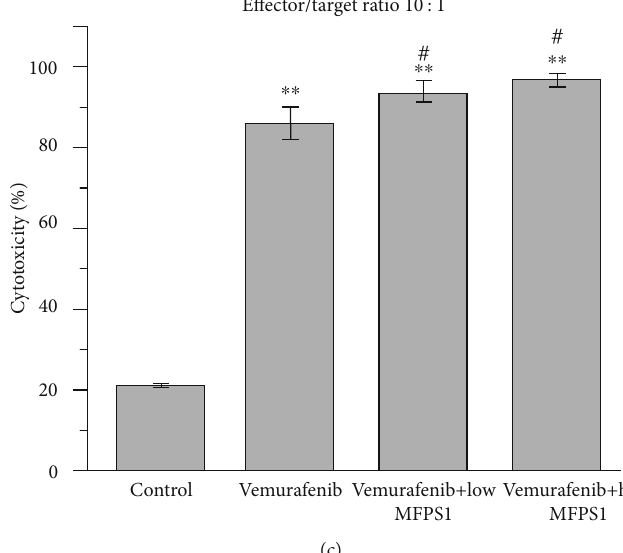
Figure 3: In vivo experiments, MFPS1 enhance the killing e ff ect of Vemurafenib on human melanoma MeWo cells. (a) Killing e ff ects on the human melanoma MeWo cells at target ratios of 1 :1, 5:1, and 10 :1 after drug treatment; (b) killing e ff ects on the human melanoma MeWo cells at target ratio of 5:1 after drug treatment; (c) killing e ff ects on the human melanoma MeWo cells at a target ratio of 10 :1 after drug treatment. ∗ represents the normal group as the control: ∗ p < 0 : 05 and ∗∗ p < 0 : 01 ; # represents the Vemurafenib group as the control: # p < 0 : 05 and ## p < 0 : 01